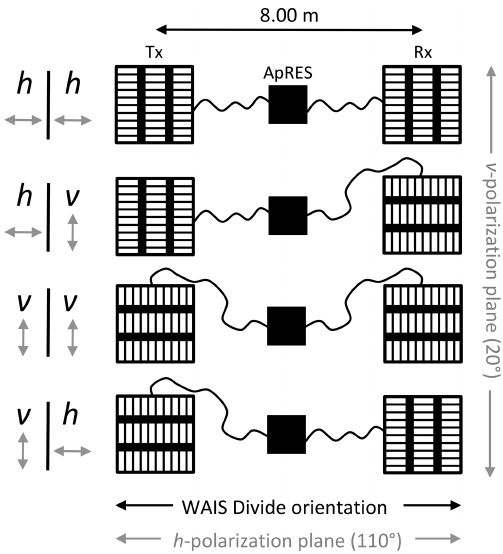
Figure 1. Four orthogonal combinations of antenna orientations as used for the polarimetry experiments in this study. Antennas (Tx: transmitting; Rx: receiving) were positioned 8 . 00m apart and ro- tated 90 ◦ in a vertical ( v ) or horizontal ( h ) orientation. The orienta- tion nomenclature (Tx | Rx) is with respect to the electric field of the antenna (grey arrows). The h -polarization plane (110 ◦ ) was oriented approximately parallel with the WAIS Divide